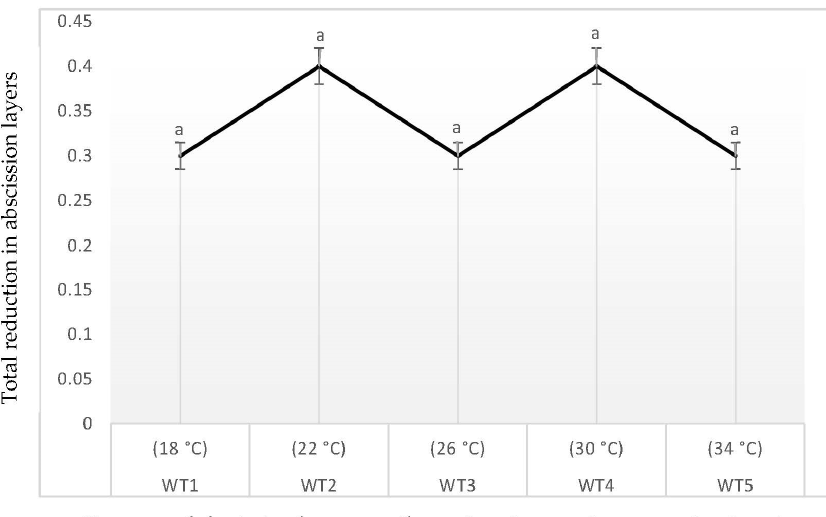
Figure 7. Root zone heating has the effect of minimizing abscission layers on S. formosus. Note: The line graph presented here depicts means of reduction in abscission layers ± SE. The mean values followed by the same letters are not significantly different (ns) at p ≤ 0.05 as calculated by Fisher’s least significant difference.